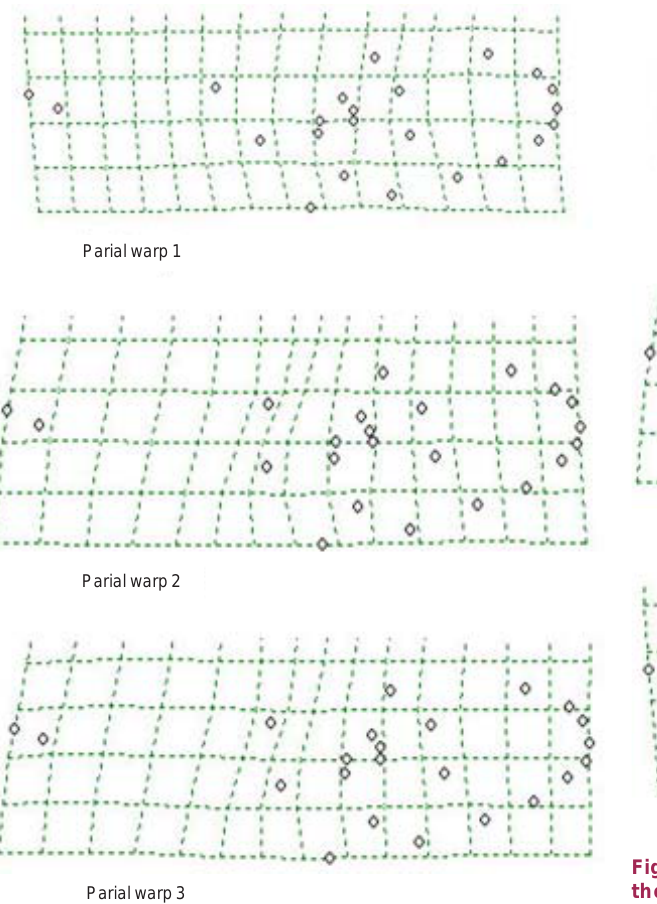
Figure 3. Plots of last three principal warps as displacement deformation equally for x and y coordinates (Alpha = 1)